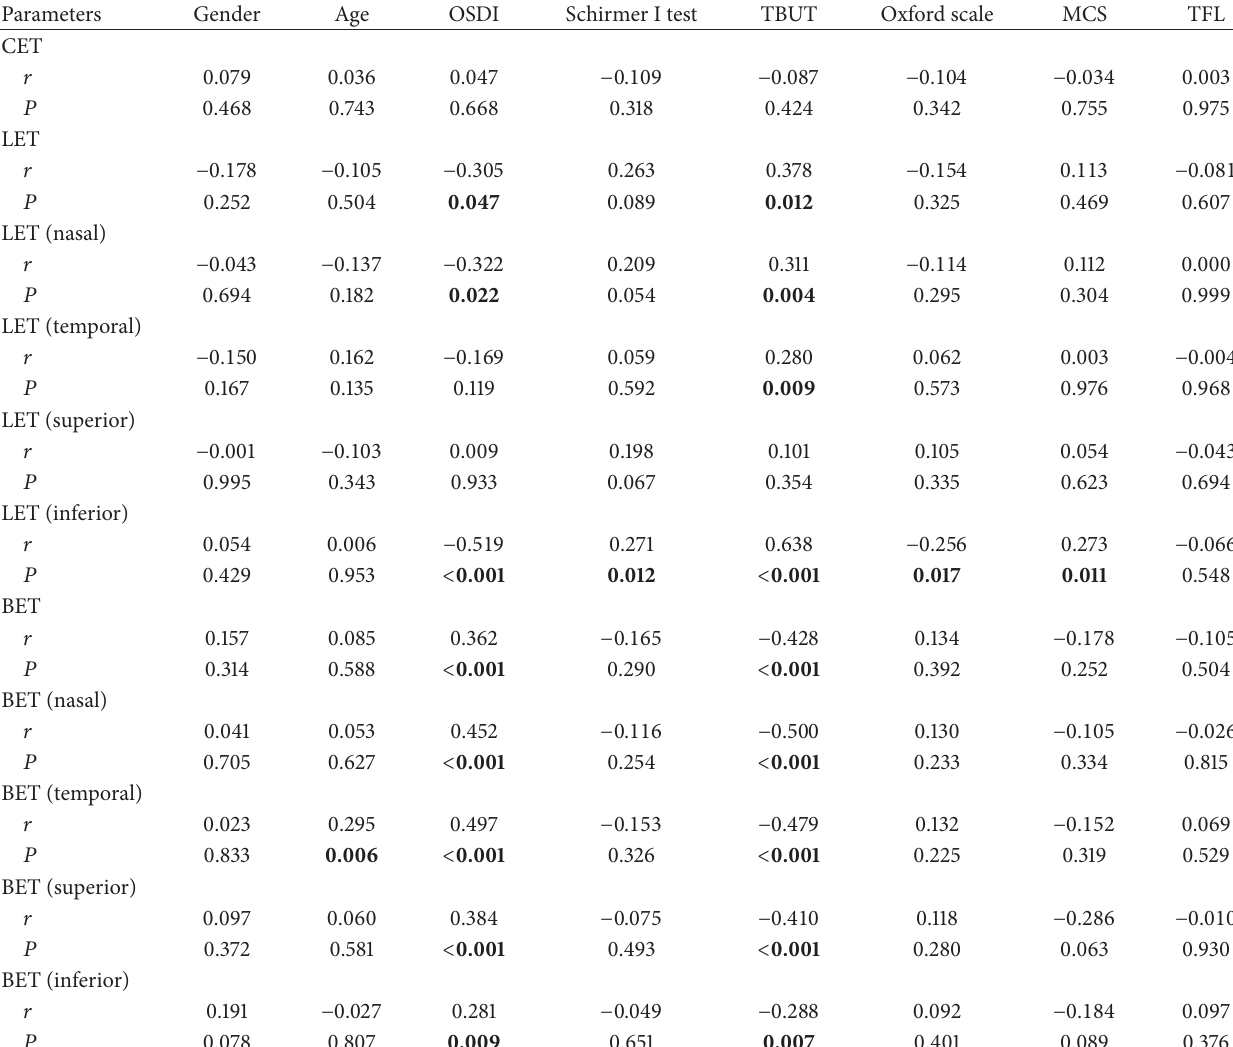
Table 4: Correlations of ocular surface epithelial thickness with the result of clinical tests in the DED group.